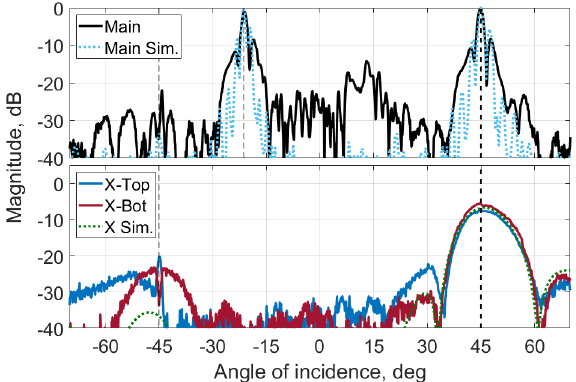
Figure 13. Radiation angle measurements and simulation for the main mode and the cross polarization couplers. At -45 degrees one can see the reflection of the main lobe due to non-perfect absorbtion at the other waveguide port. The second main lobe of the main mode coupler is related to the LP 0 n suppression.